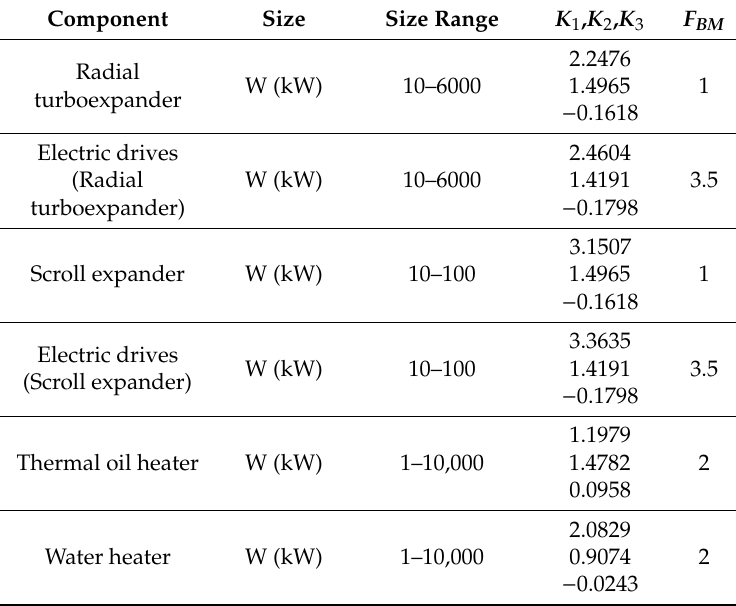
Table 3. MCT cost coe ffi